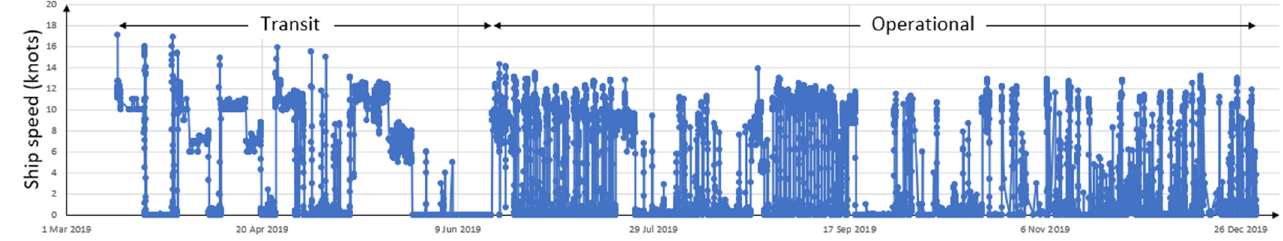
Figure 6. Speed profile for MPSV.